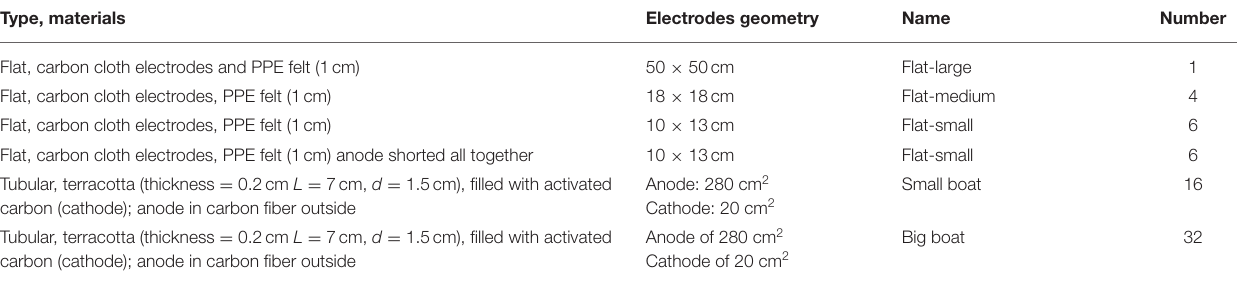
TABLE 1 | Characteristics of the MFCs types. Type,